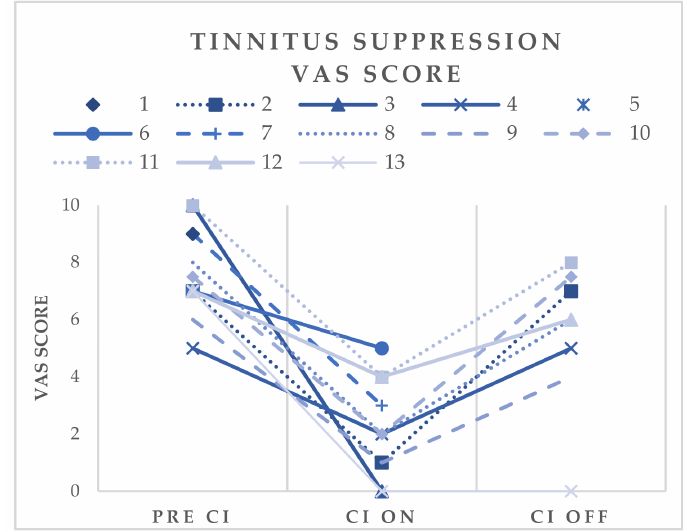
Figure 1. Tinnitus suppression. Evolution of VAS scores in 13 implanted patients. Pre CI = before cochlear implantation; CI on = speech processor of cochlear implant switched on; CI off = speech processor of cochlear implant switched